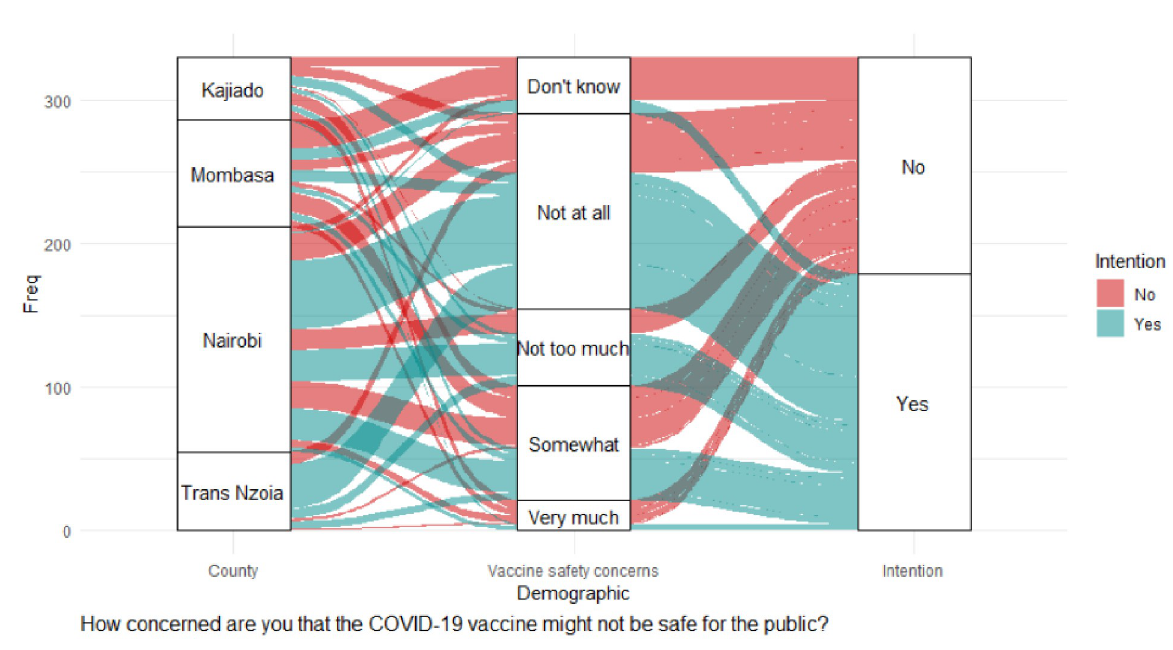
Fig 7. Concerns about COVID-19 safety.